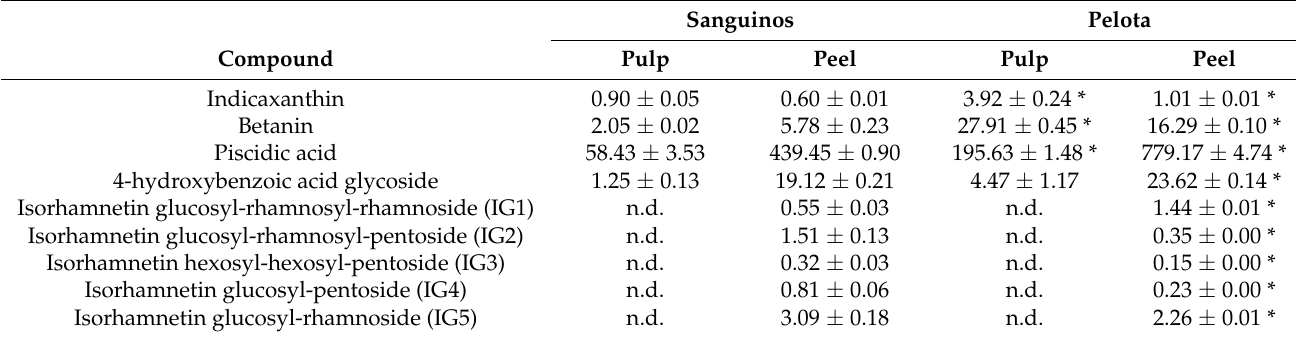
Table 1. Betalain and phenolic content (mg/100 g fresh weight) in rehydrated Sanguinos and Pelota prickly pear ( Opuntia ficus-indica L. Mill.) peels and pulps. Sanguinos Pelota Compound Pulp Peel Pulp